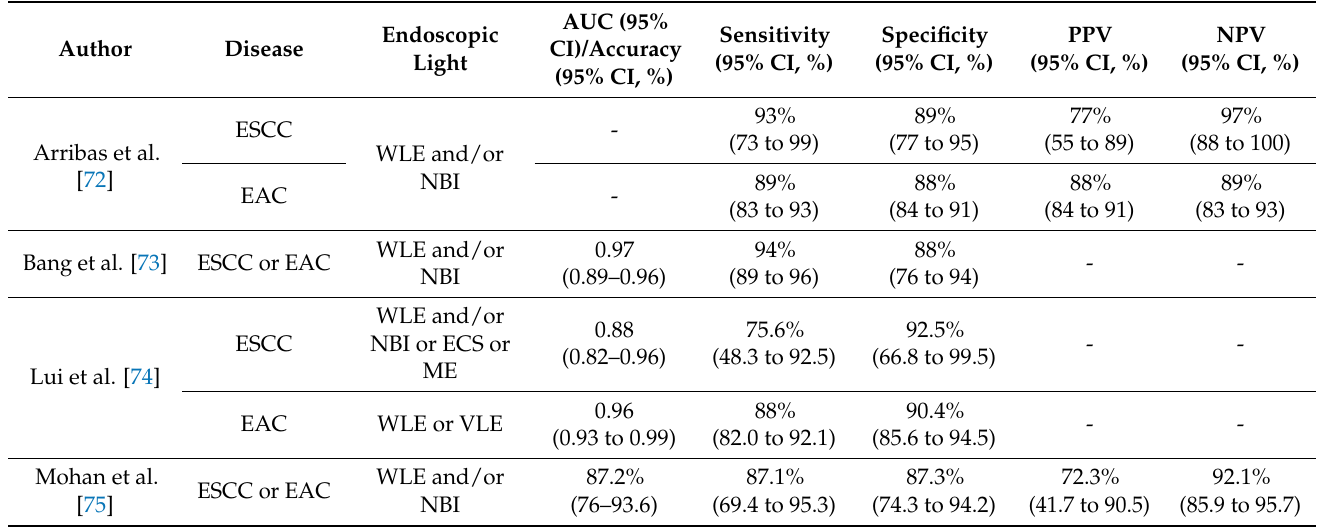
Table 3. Performance of artificial intelligence in the diagnosis of esophageal cancer according to